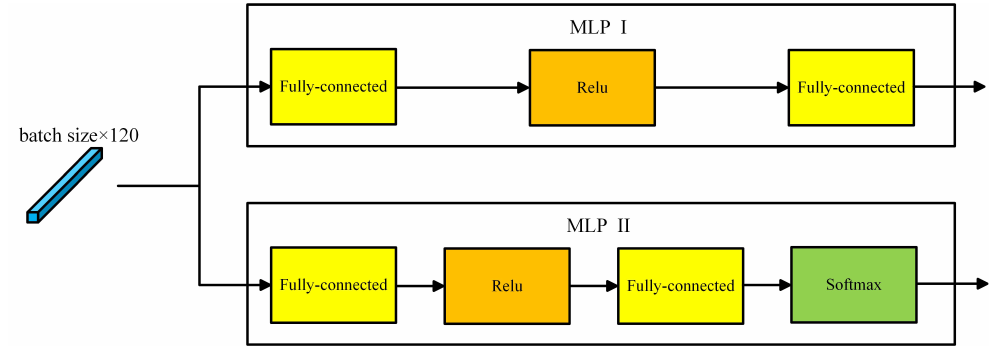
Figure 4. The architecture of our MLPs.